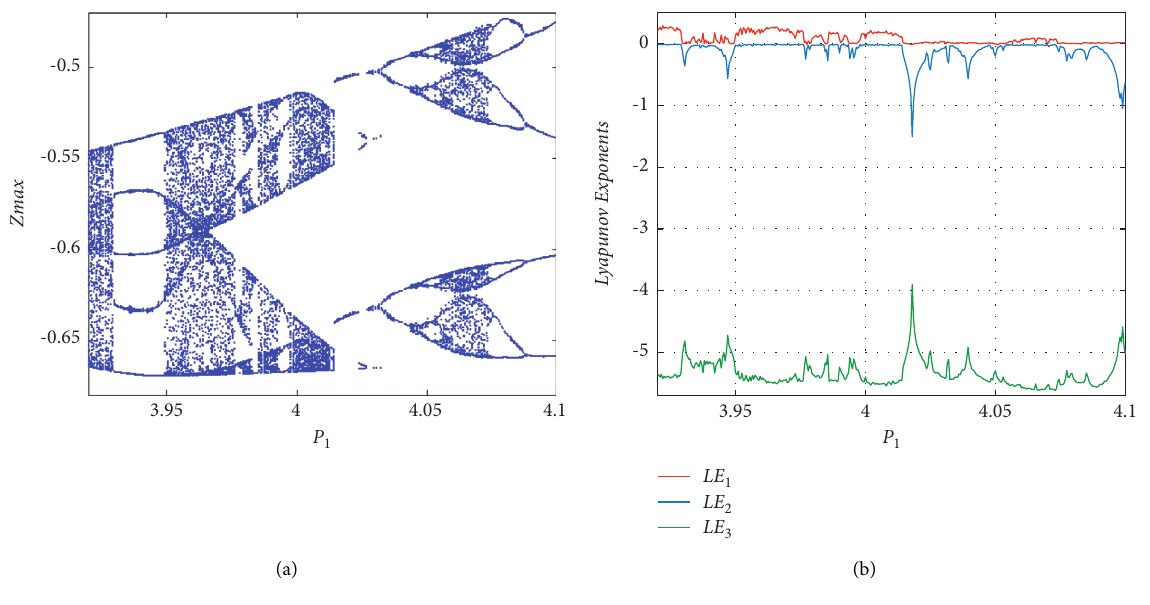
Bifurcation diagram and LEs